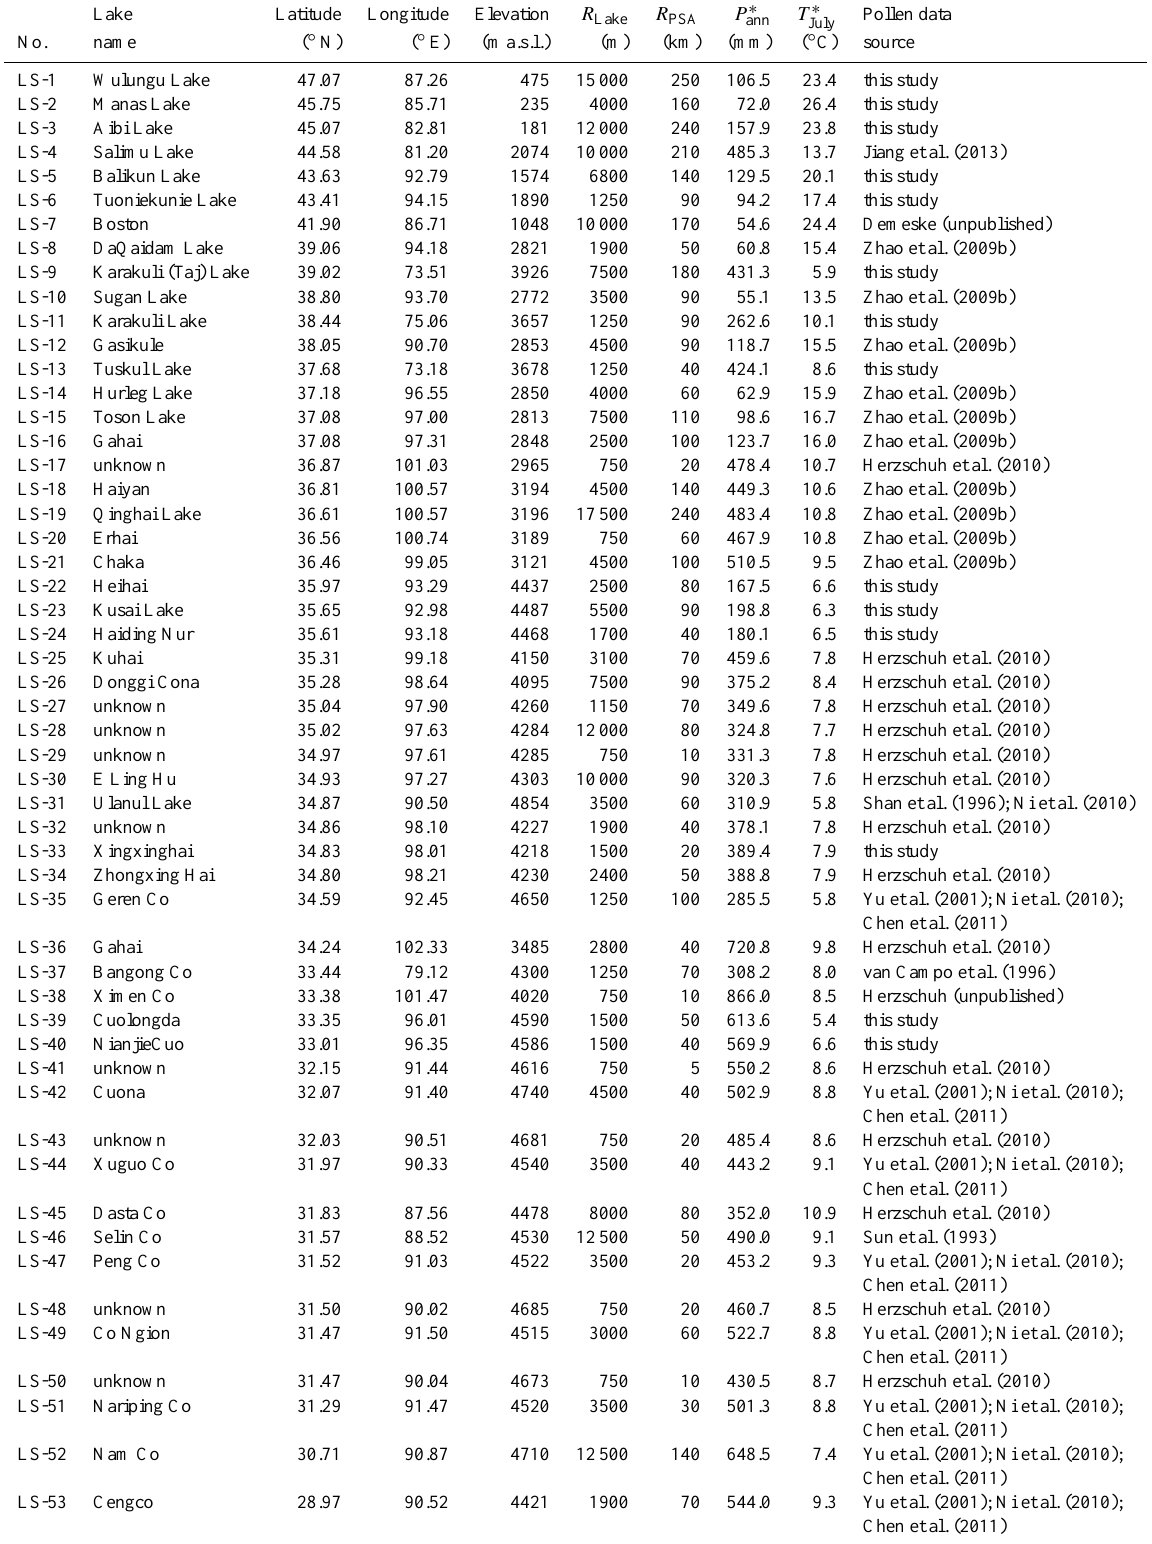
Table 1. Location, lake size, calculated pollen source area and corresponding climate data from large lakes.